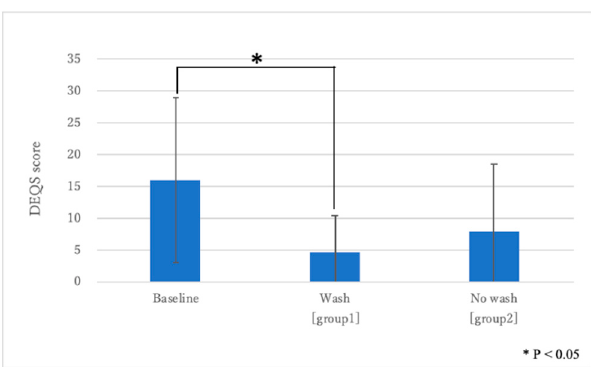
Figure 1. Changes in the dry eye-related quality-of-life score (DEQS) score. Note the significant improvement between before and after 1 month of eyewash use ( p = 0.001).